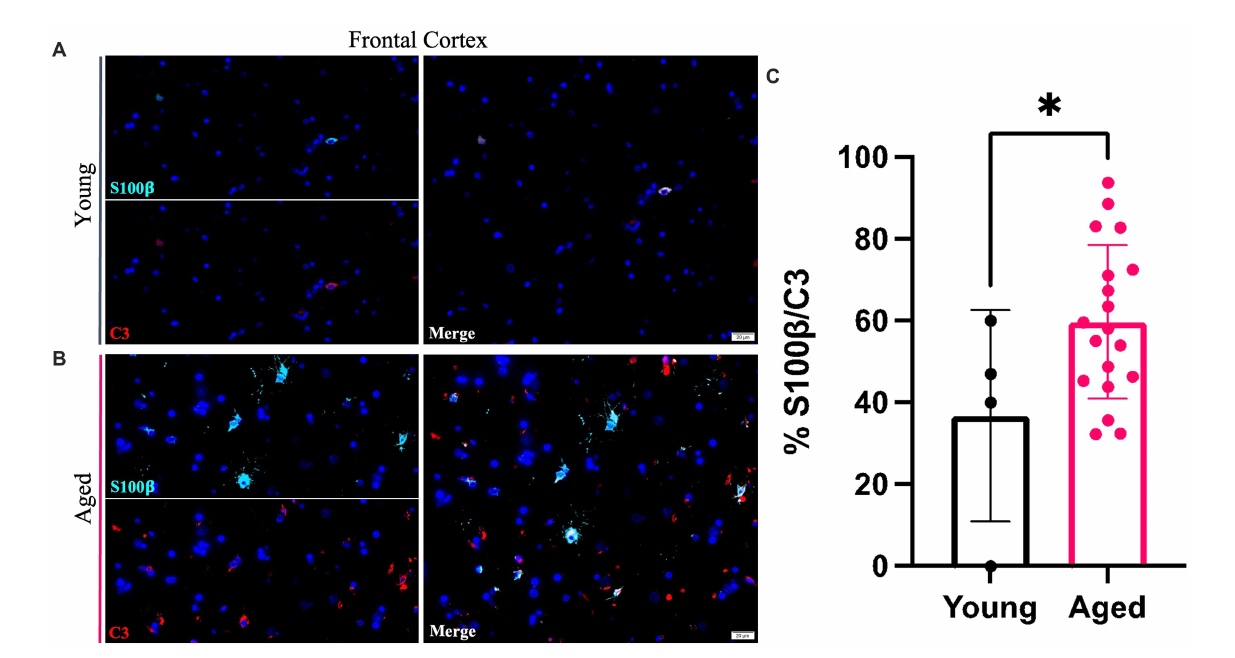
FIGURE 3 A1 reactive astrocytes increase within the cortex of the aging canine. An increase in C3 (red) co-localized with pan astrocyte marker S100b (green) is seen in aged canines (B) compared to young animals (A) . Quantification of these cells in the cortex reveals a significant increase in A1 astrocytes with age in this brain region (C) . ( n = 22). Scale bar = 20 μM Unpaired t -test, p = 0.0486, error bars = SEM, p <